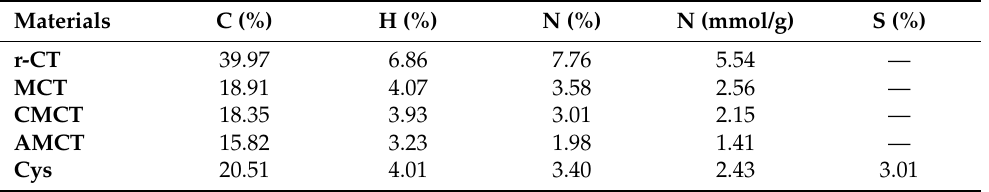
Table 1. Elemental analysis of nanocomposite synthesis